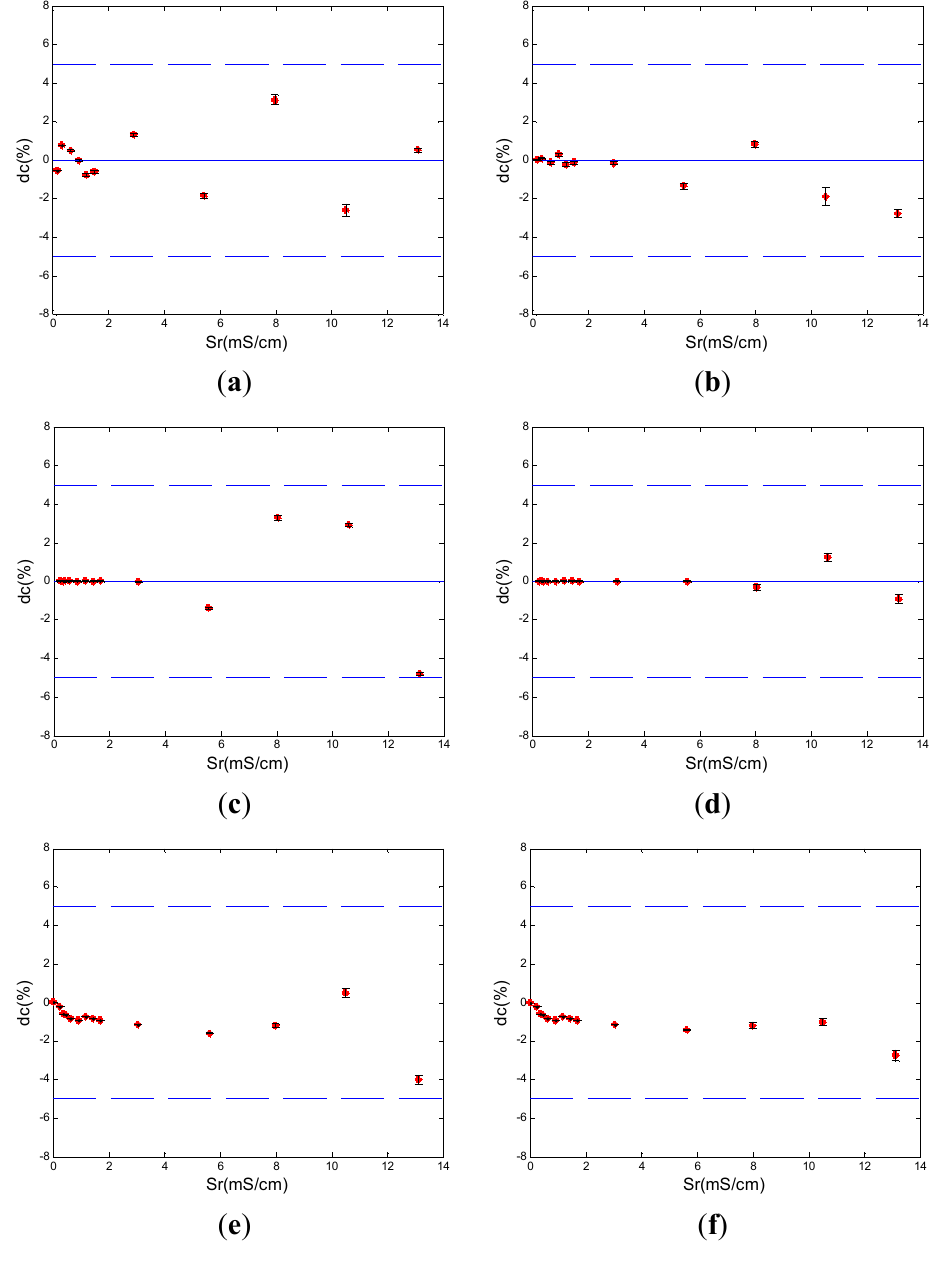
Figure 4. Experimental results by using the new five-electrode C 4 D sensor in five